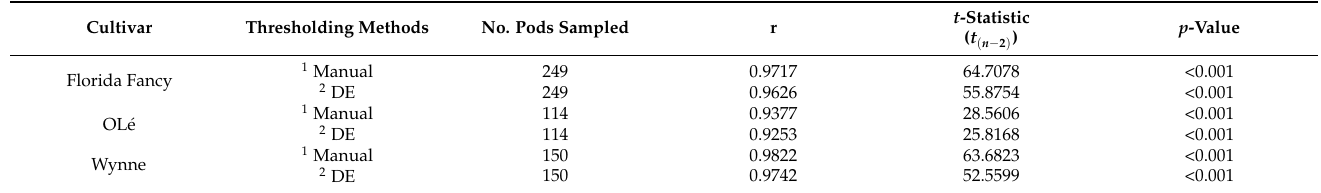
Table 2. Correlation coefficients between CAI values and peanut seed weights.